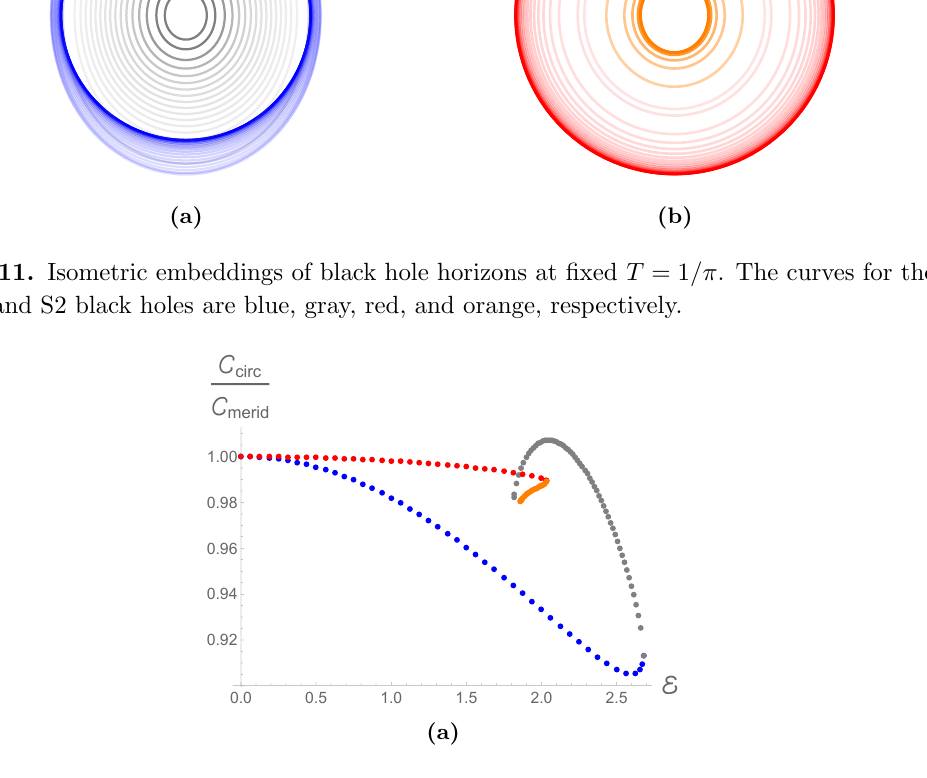
Figure 12. The ratio of the circumferences at the horizon equator and a meridian at (cid:12)xed T = : 396. As the electric (cid:12)eld is increased, the black holes becomes slightly deformed but do not pinch at the equator as in [1]. This is one of the main qualitative di(cid:11)erences from coupling the polarized black holes to a scalar